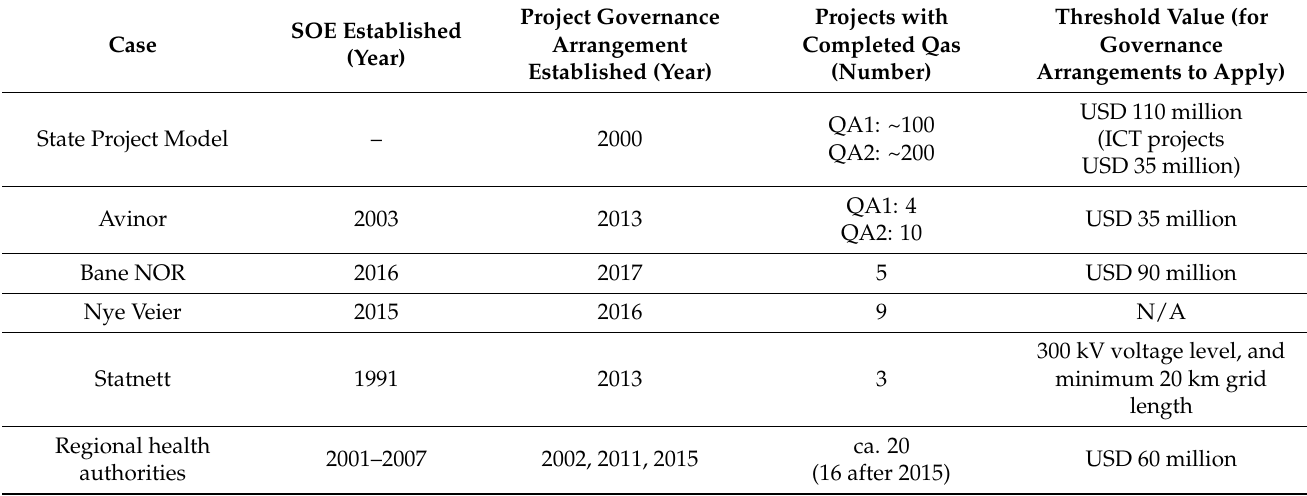
Table 3. Overview of the case SOEs’